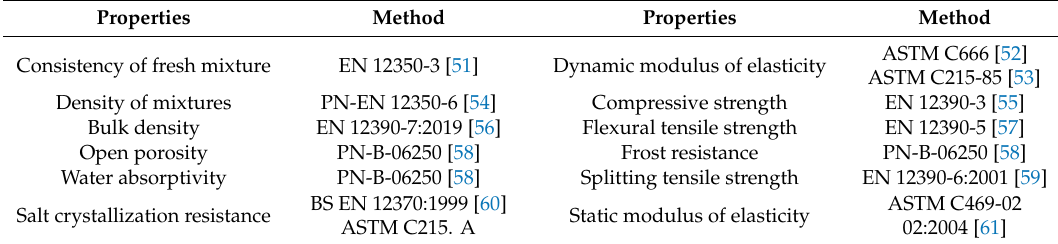
Table 3. Experimental methods and properties of concrete with and without POFs.